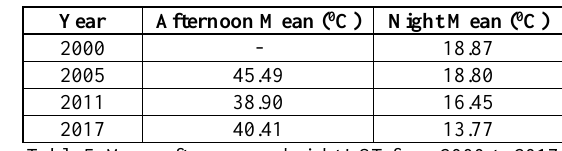
and 2011 which indicates a similar trend with the morning LST (Table 4).